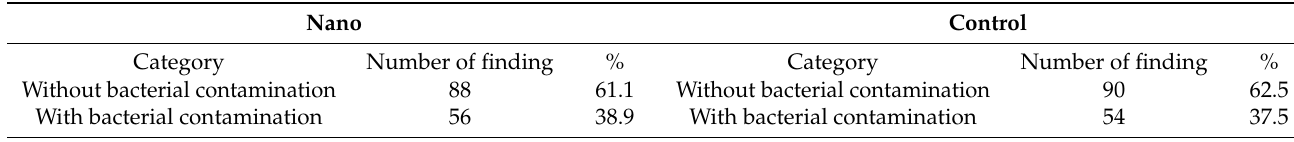
Table 2. Culture results in